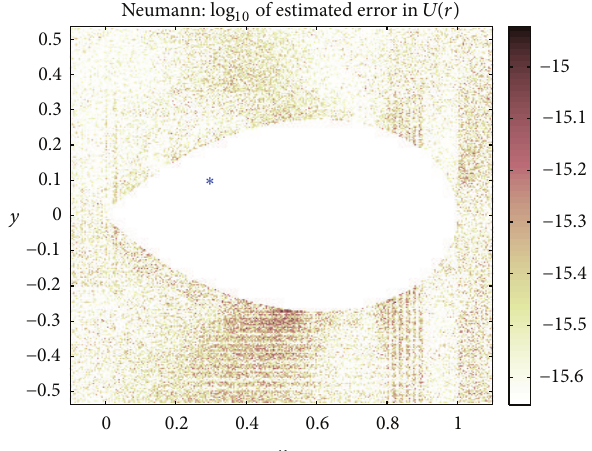
Figure 18: Same as Figure 17, but the exterior Neumann Helmholtz problem is solved using demo13d.m . The accuracy is even higher than in Figure